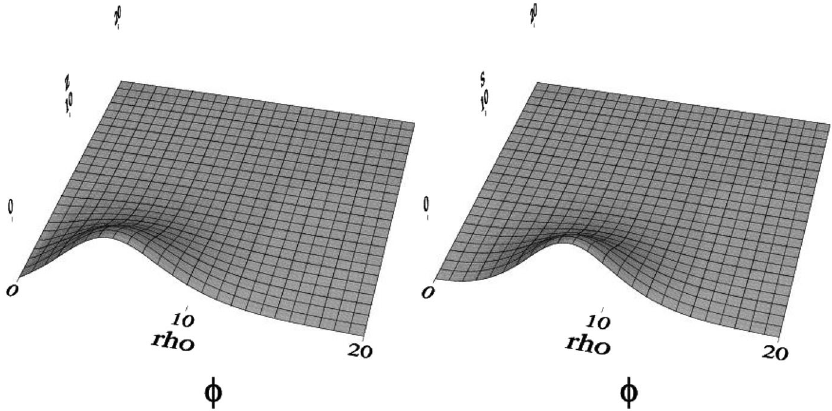
Fig. 7 Thescalar fi eldincylindricalcoordinates / ð q ; z Þ fortworotatingboson-starsolutions:(left) k ¼ 1and (right) k ¼ 2. The two solutions have roughly comparable amplitudes in scalar fi eld. Note the toroidal shape. Reproduced with permission from Lai (2004) Fig. 8 Radial pro fi les along the equator of rotating boson stars for fi xed x ¼ 0 : 8 ð m = (cid:1) h Þ and k 2 ½ 0 ; 6 (cid:11) . Reproduced with permission from Ontanon and Alcubierre (2021), copyright by IOP, which uses l in place of k to indicate the azimuthal quantum